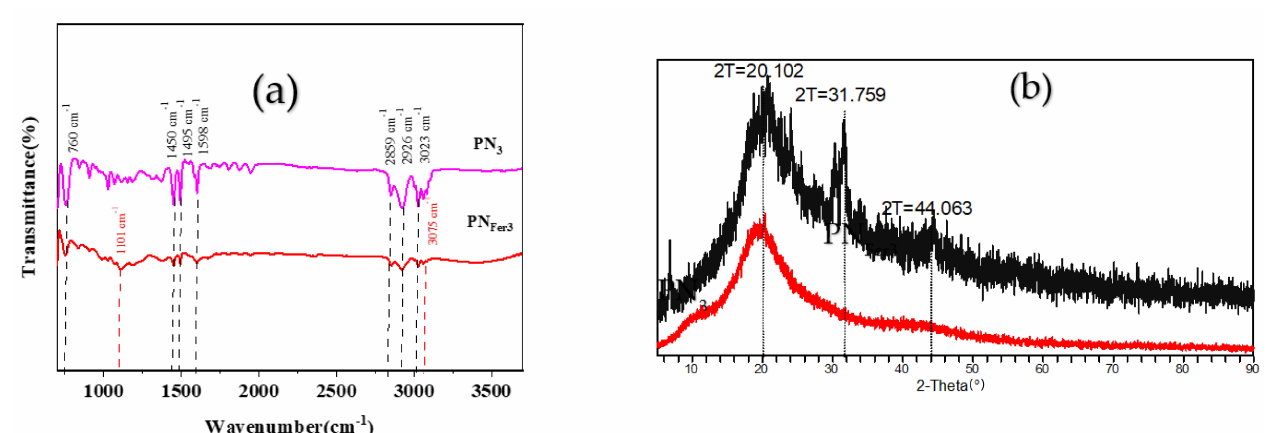
Figure 3. RRS, Abs and fluorescence spectra of polystyrene nanospheres. ( a ) RRS spectra of the curves a to g: (0.5, 1, 2, 3, 5, 10, 20) mg/L PN 3 ; ( b ) RRS spectra of the curves a to g: (0.5, 1, 2, 3, 5, 10, 20) mg/L PN Fer3 ; ( c ) Abs spectra of 10 mg/L PN 3 and PN Fer3 ; ( d ) fluorescence spectra of 10 mg/L PN 3 and PN Fer3 .